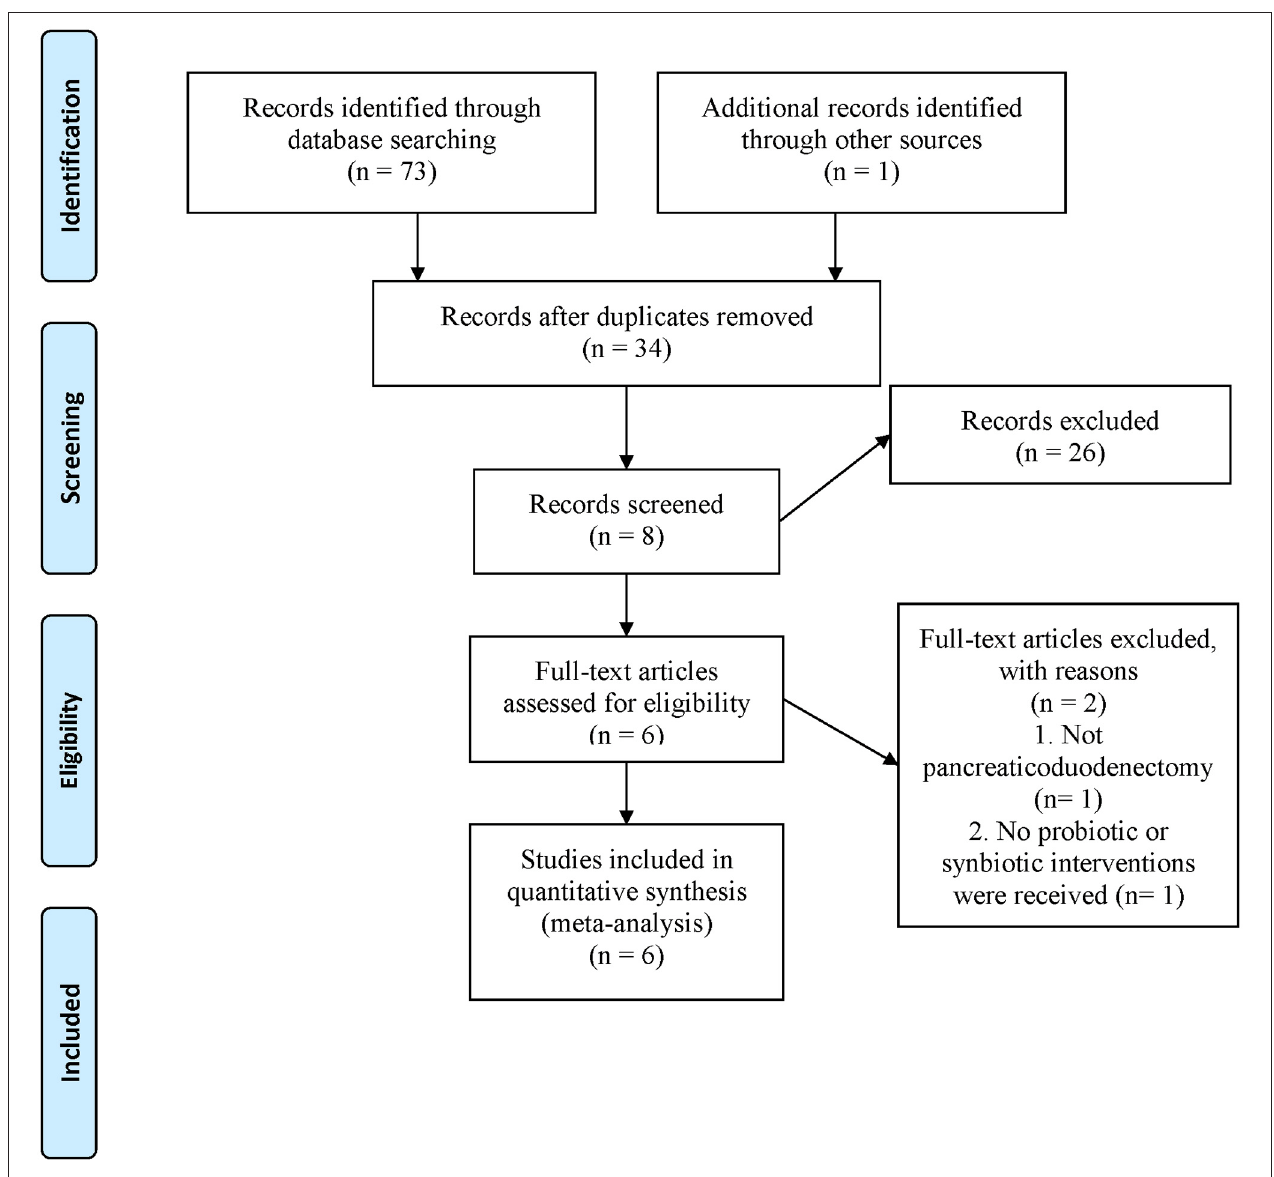
FIGURE 1 | Flow chart of literature search and